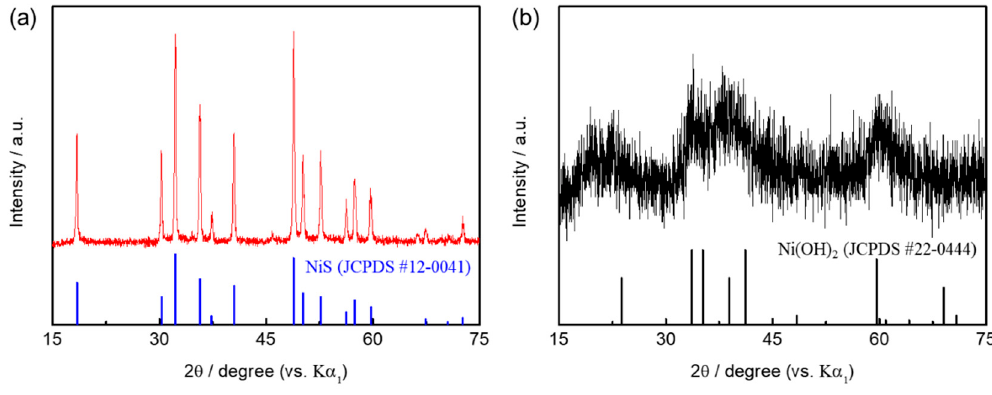
Figure 1. XRD patterns of ( a ) NiS and ( b ) Ni(OH) 2 .